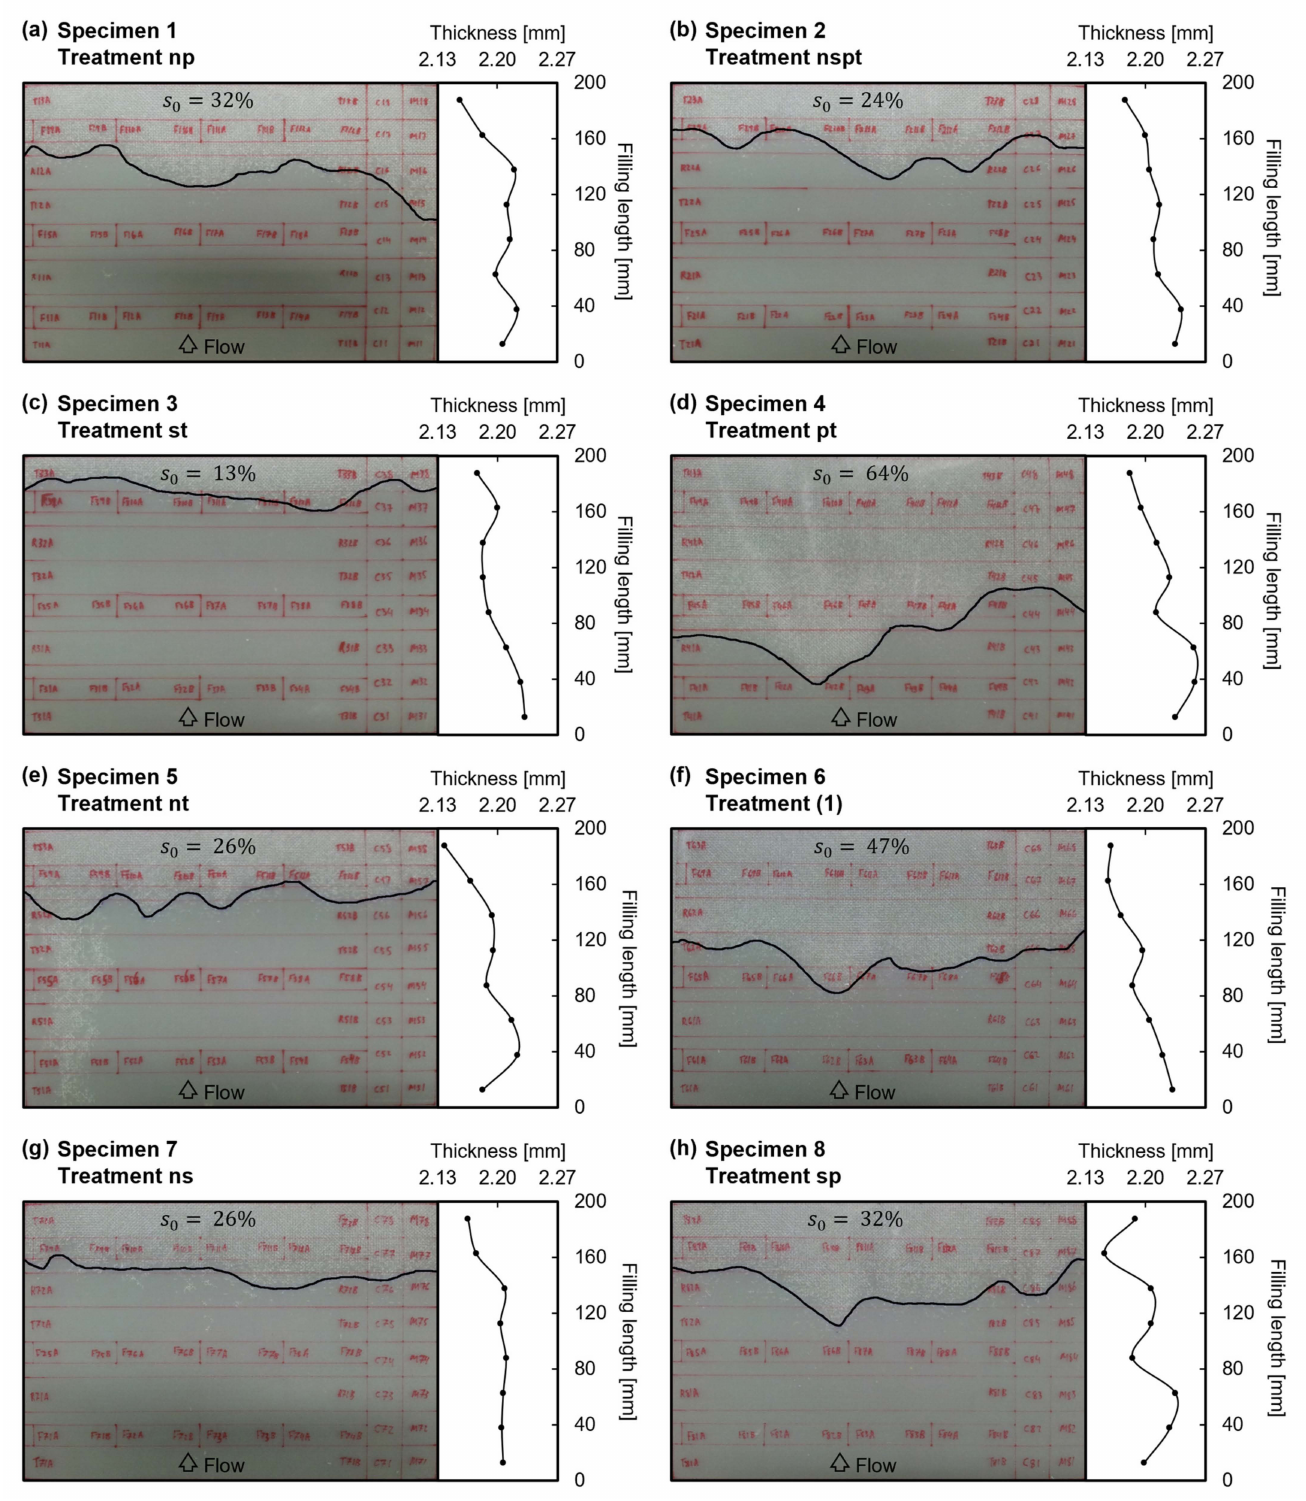
Figure 6. Scaled photographs of the manufactured specimens’ useful area (300 mm × 200 mm): ( a ) Specimen 1, treatment np; ( b ) Specimen 2, treatment nspt; ( c ) Specimen 3, treatment st; ( d ) Specimen 4, treatment pt; ( e ) Specimen 5, treatment nt; ( f ) Specimen 6, treatment (1); ( g ) Specimen 7, treatment ns; ( h ) Specimen 8, treatment sp. Samples marked in red on specimens’ top face; boundary of the porous area fraction, s 0 , digitally underlined in black; and thickness profile measured at samples MYZ along the filling